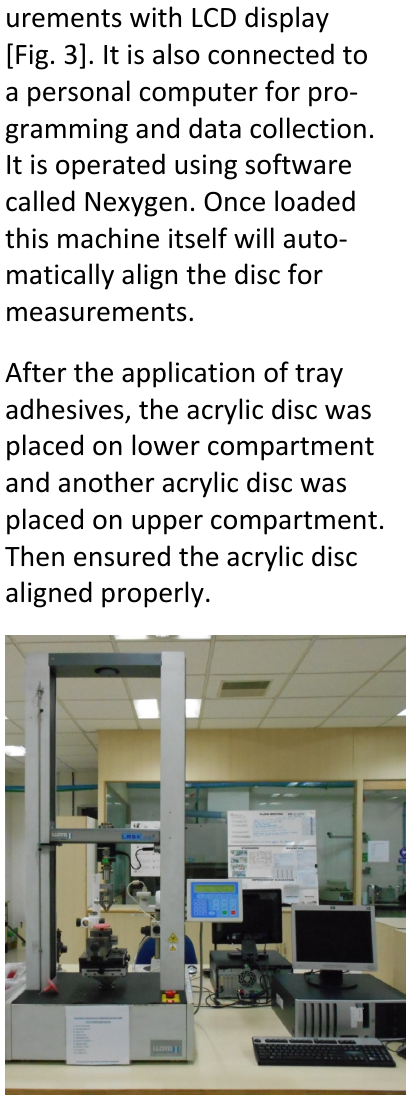
Figure 3. Universal Tes3ng Machine [LR5K